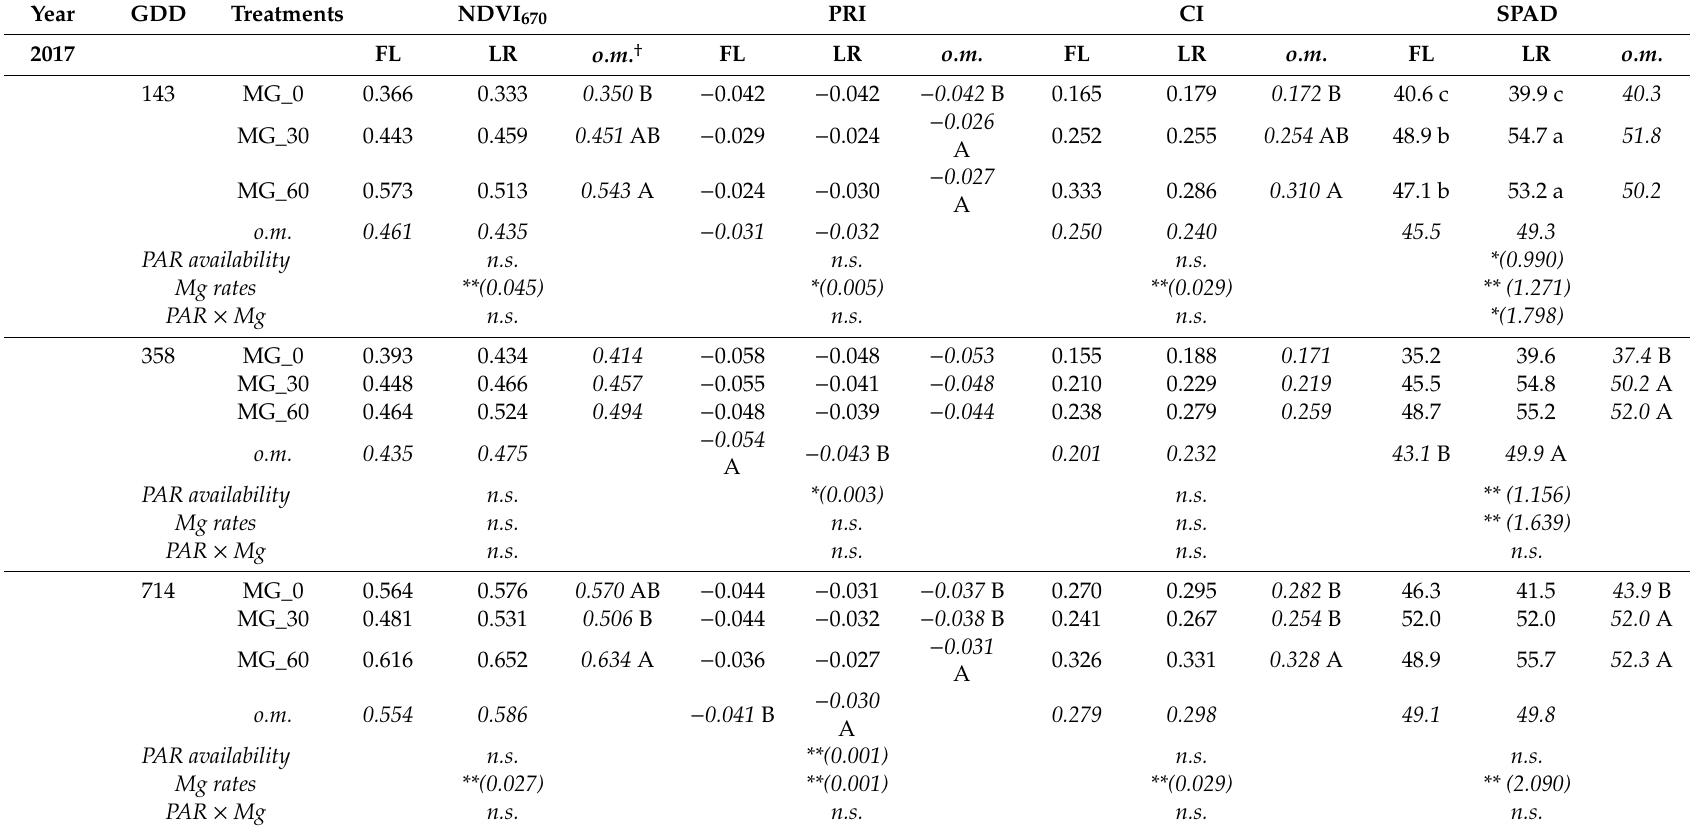
Table 4. Normalized Di ff erence Vegetation Index (NDVI 670 ), Photochemical Reflectance Index (PRI), Chlorophyll Index (CI) and Soil Plant Analysis Development (SPAD) as recorded for red beet plants subjected to two levels of photosynthetically active radiation (PAR) availability (100% PAR availability: Full Light, FL; 50% PAR availability: Light Reduction, LR) and three magnesium (Mg) application rates (0 kg ha − 1 of Mg: MG_0; 30 kg ha − 1 of Mg: MG_30; 60 kg ha − 1 of Mg: MG_60) at 143, 358 and 714 Growing Degree Days (GDD, ◦ C) after transplanting in 2017 and at 158, 376 and 724 GDD after transplanting in 2018. Measurements are average values of three replications. Means followed by di ff erent letters (upper case letters: main e ff ects; lower case letters: e ff ects of interaction) significantly di ff er (Fisher’s LSD, p ≤